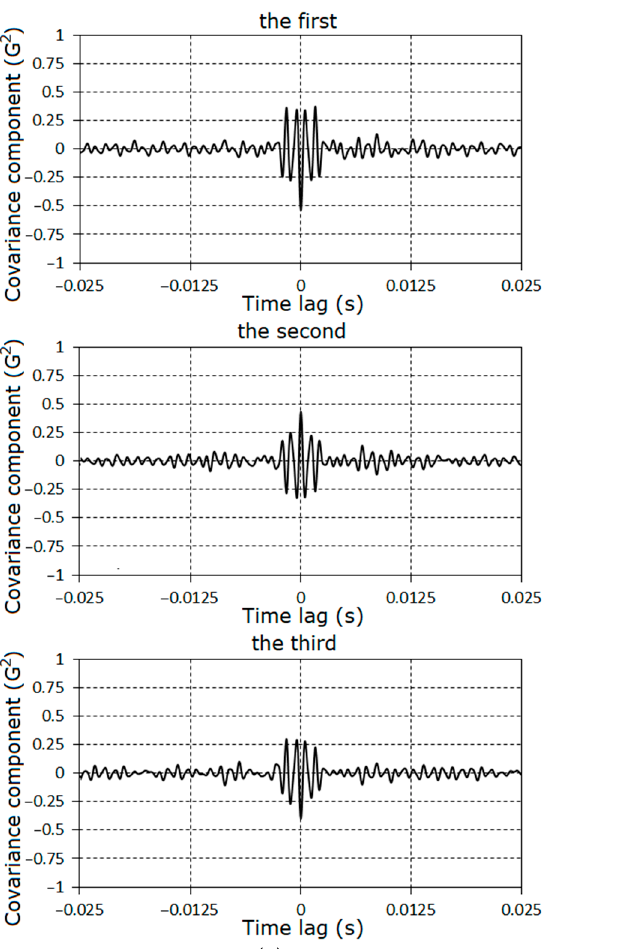
Figure 18. The dependences of the zero th covariance component estimators on the time lag for the first ( a ), second ( b ), and third ( c ) stages.